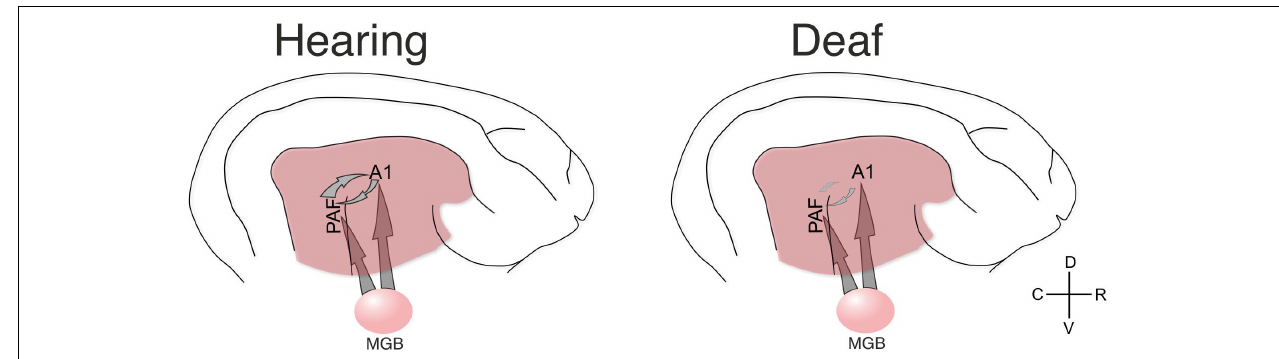
FIGURE 8 | Schematic illustration of the present results. The present data document that in hearing controls the functional connectivity between A1 and PAF is dominated by top–down interactions. Such connectivity is stronger for stimulation that the animal has previous experience with (as shown by comparing acoustic vs. electric stimulation in hearing controls). Both fields additionally receive thalamic input (not directly investigated here) that generates evoked responses and dominates in the early response window. In the deaf animal the functional connectivity in the early window was not significantly different to electric controls, but the late window did not reveal corticocortical synchronization (connectivity) and the dominating influence of top-down information flow disappeared. Yet, responses were observed in both fields, indicating some thalamic input from MGB also in deaf animals (for analysis of the evoked responses, see Yusuf et al., 2017).